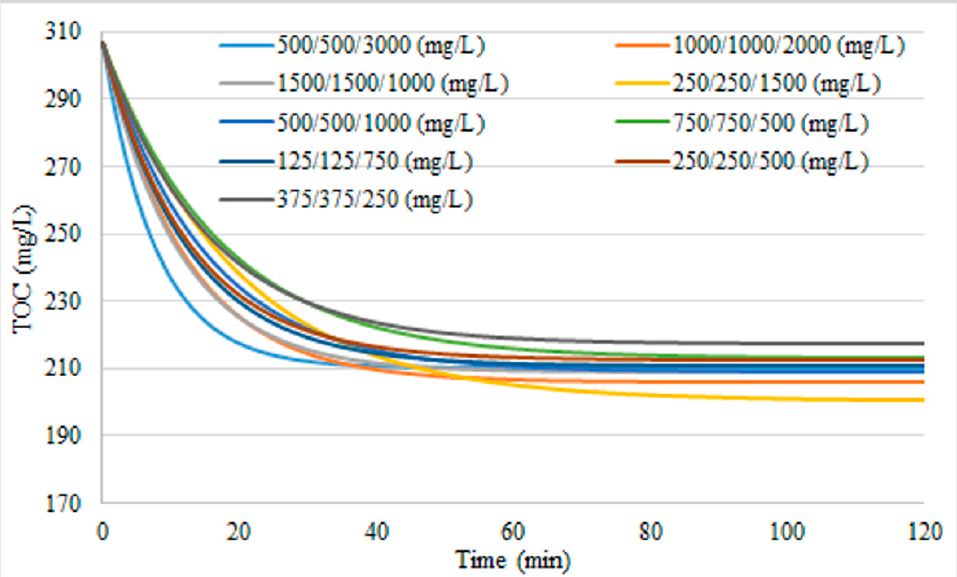
Figure 2. Cosmetic wastewater (CW) treatment results with different Fe 3 O 4 /Fe 2 O 3 /Fe 0 doses (mg/L) H 2 O 2 /COD mass ratio 1:1, without UV irradiation, pH = 3.0.